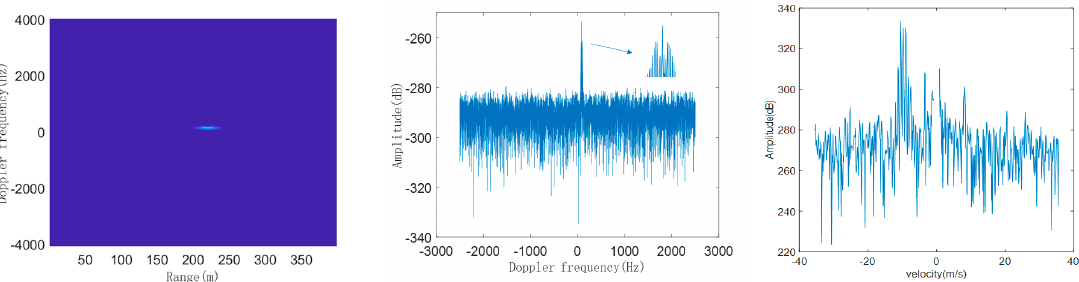
Figure 8. Simulated RD plane ( left ), simulated single-frame DMS ( middle ), and real measured DMS ( right ) of bird.